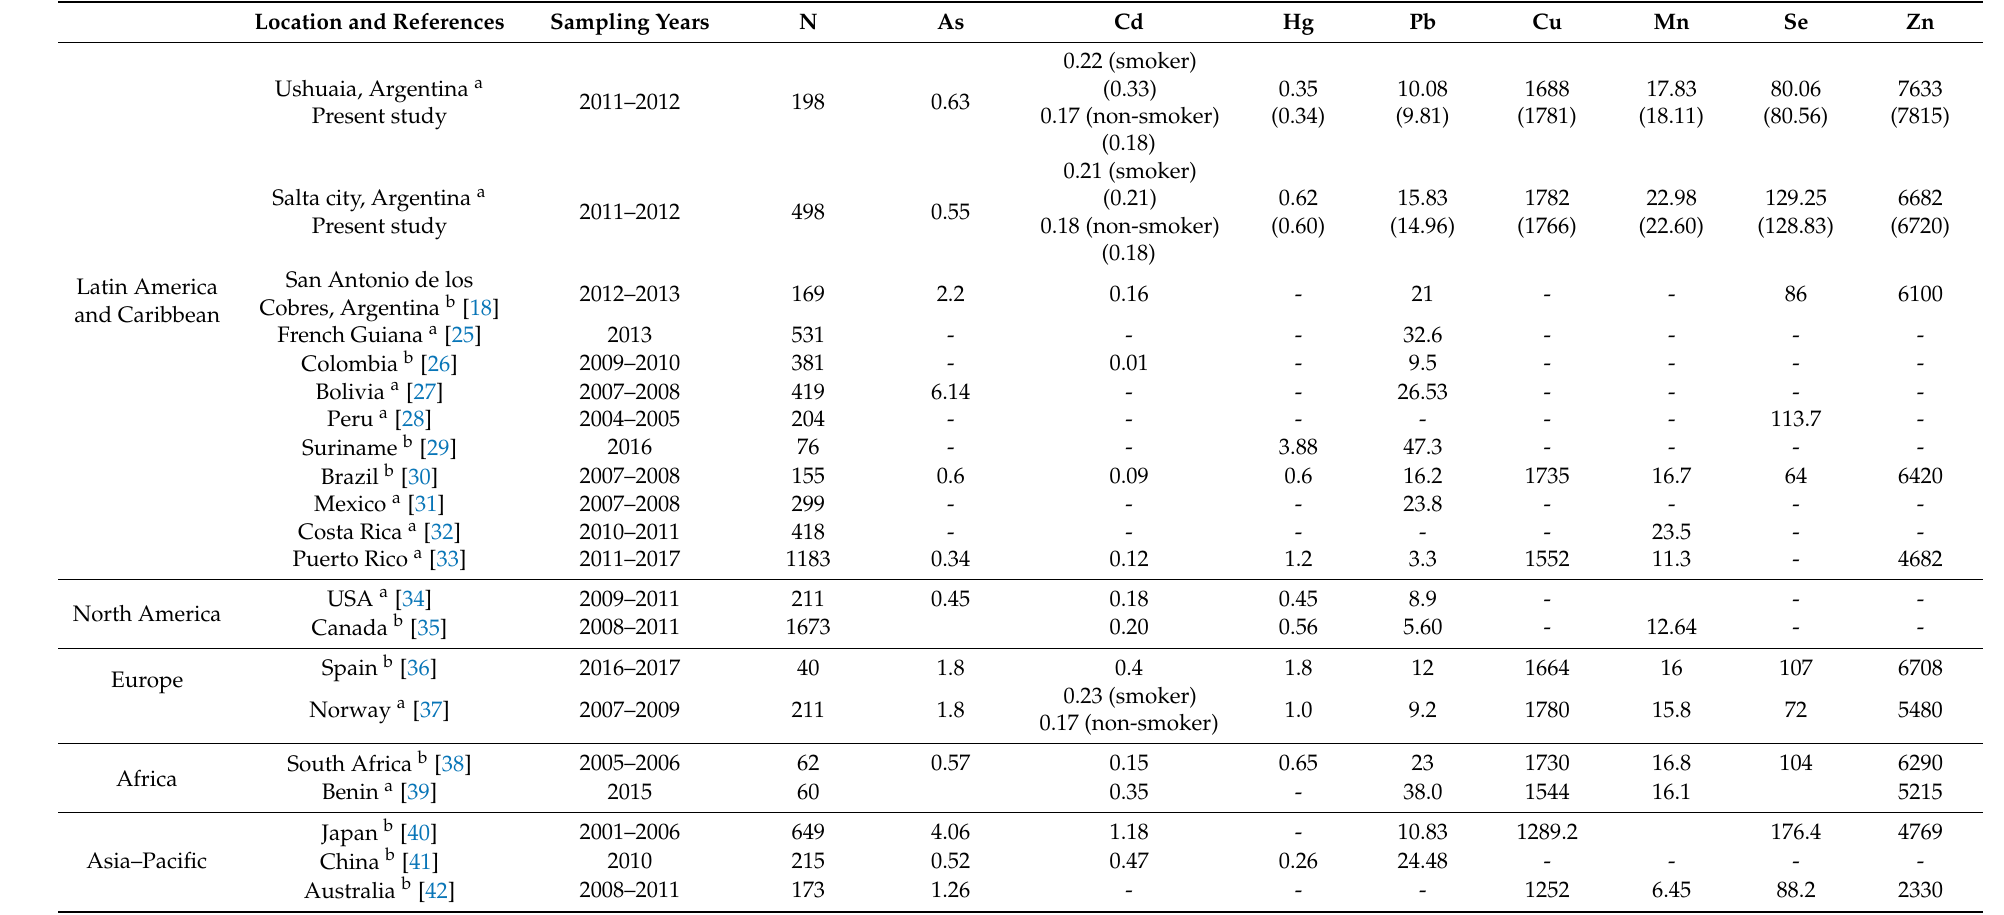
Table 3. Global Comparisons of blood elements concentrations among pregnant women or delivering women ( µ